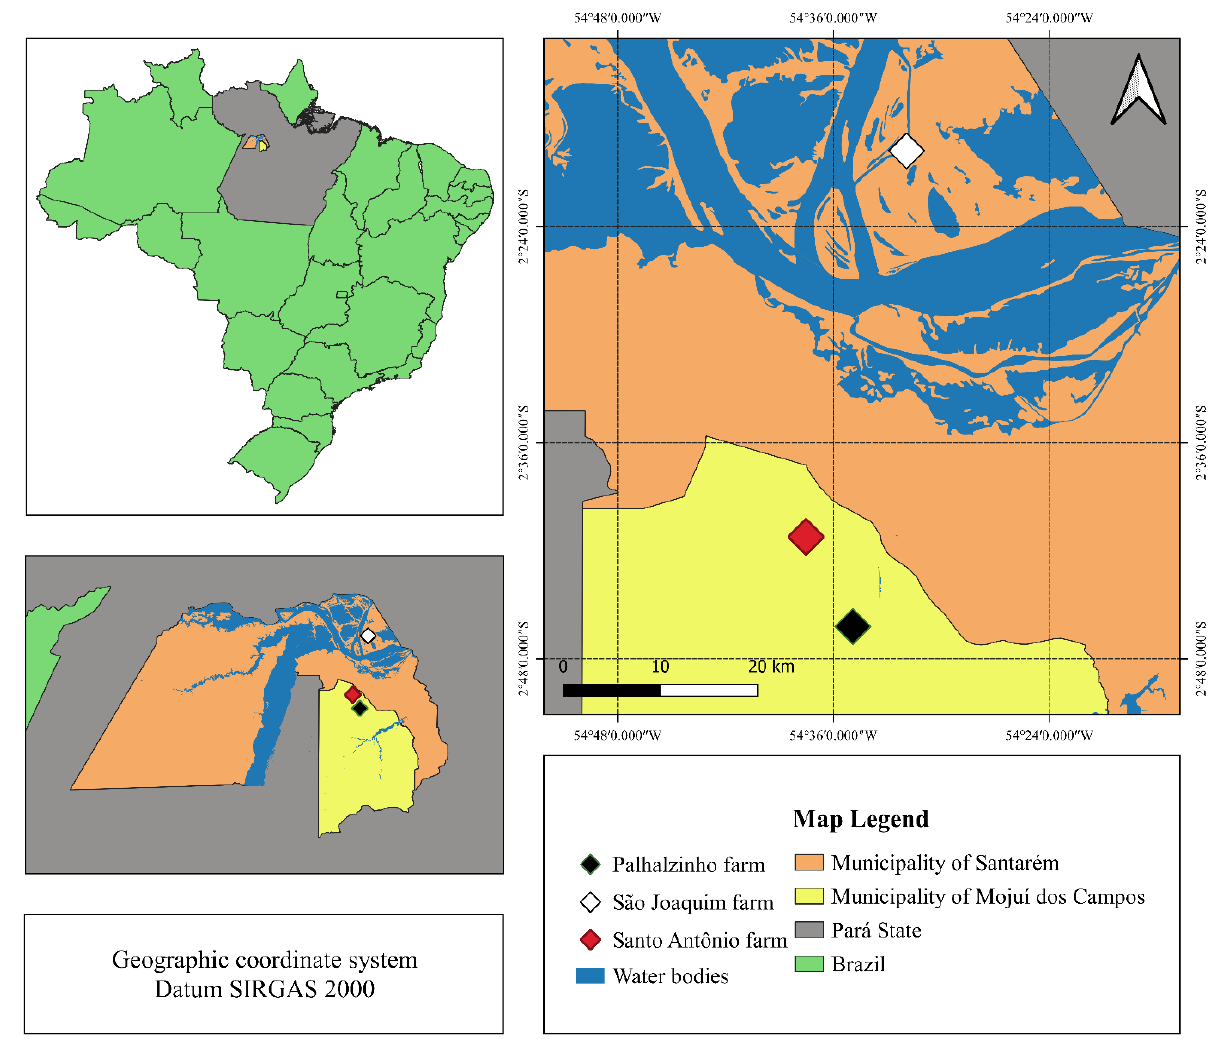
Figure 1. The location of the farms where ticks were collected.